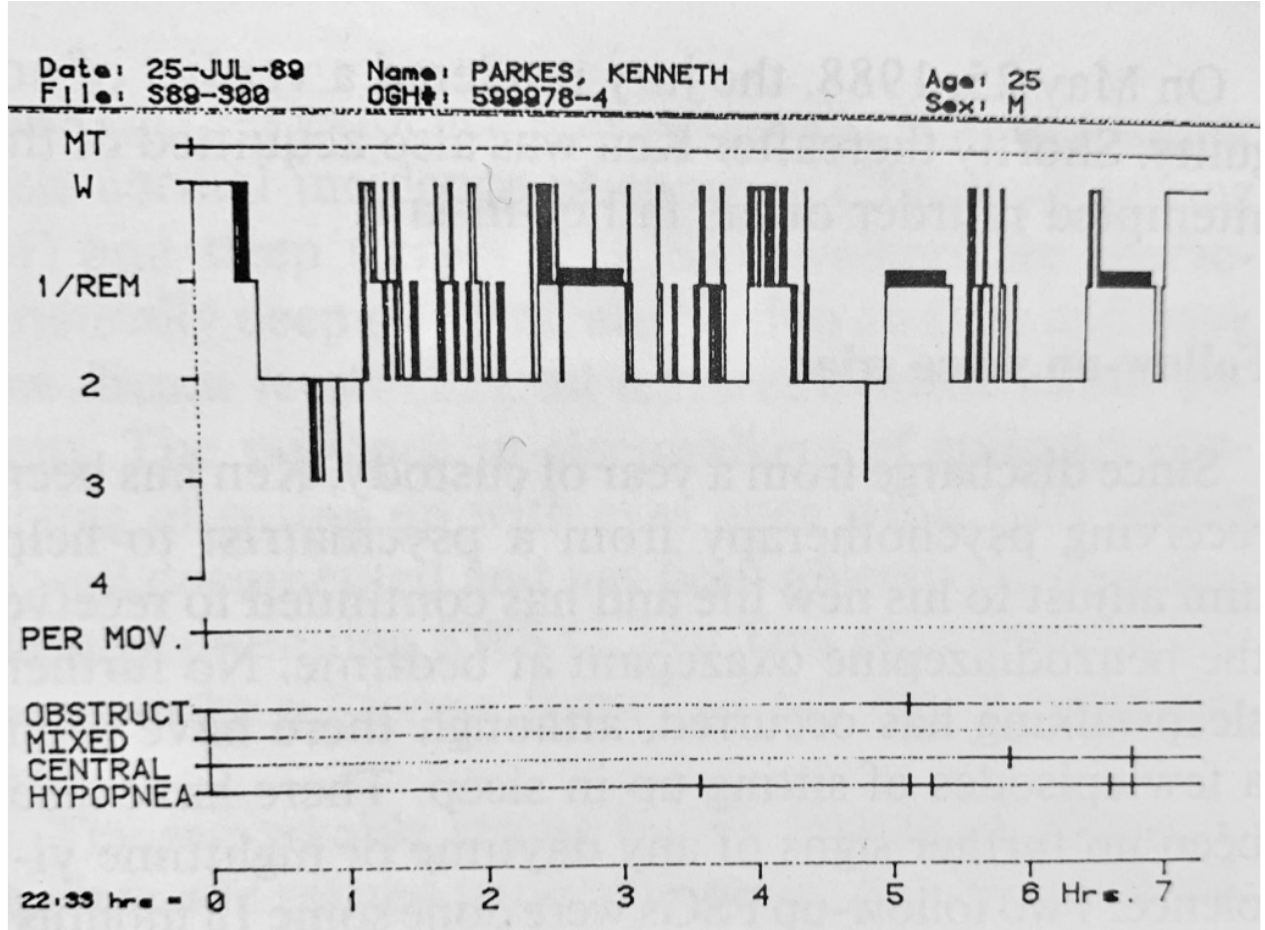
Figure 15. Histogram of the sleep of Ken Parks some 18 months after the homicide. He had been treated by the benzodiazepine clonazepam during this period. Like with all benzodiazepines there is more or less total suppression of deep slow ‐ wave sleep. There was only a single direct transition from SWS to wake and this occurred about one hour after sleep onset. (Reproduced with permission from Broughton R, Billings R, Cartwright Ret al. Homicidal Somnambulism: A Case Report. Sleep, Volume 17, Issue 3, May 1994, Pages 253–264, https://doi.org/10.1093/sleep/17.3.253, published by Oxford University Press).